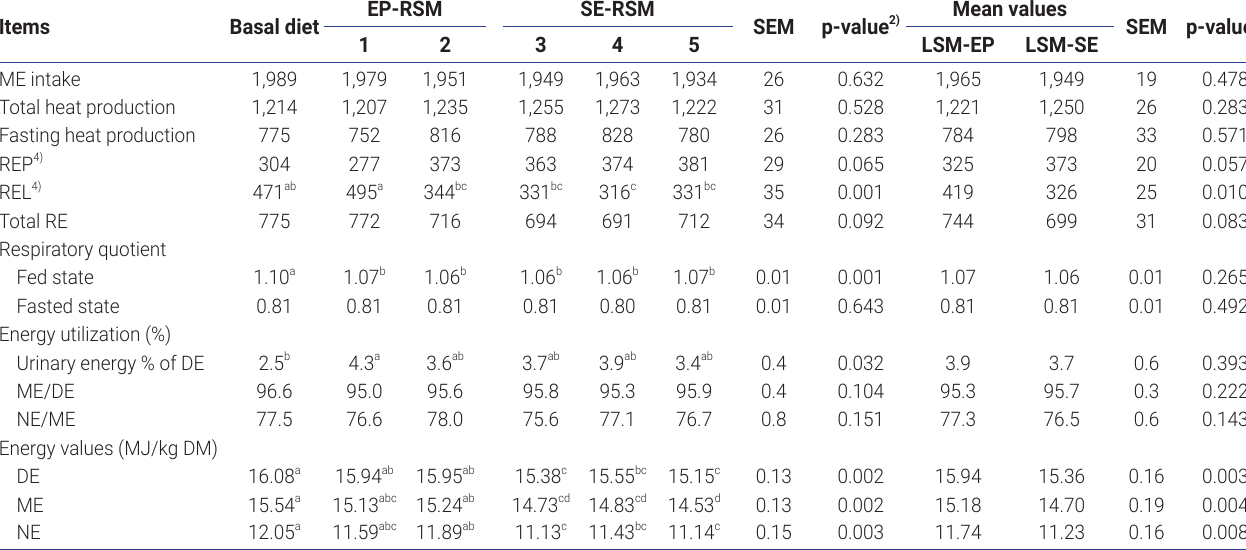
Table 4. Effect of diet characteristics on energy balance of growing pigs